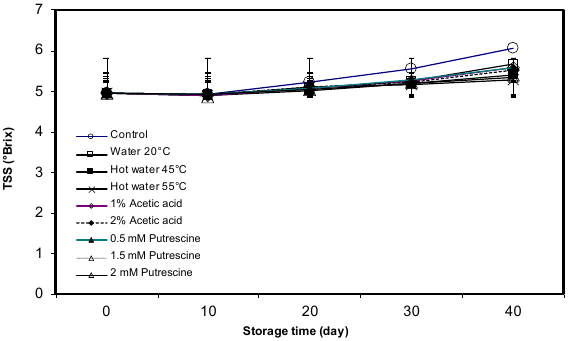
Figure 4. Mean total soluble solids (TSS; ± standard deviation; n = 3) of cv. Shahrodi apricots before and during storage for 40 d at 5°C following different treatments.